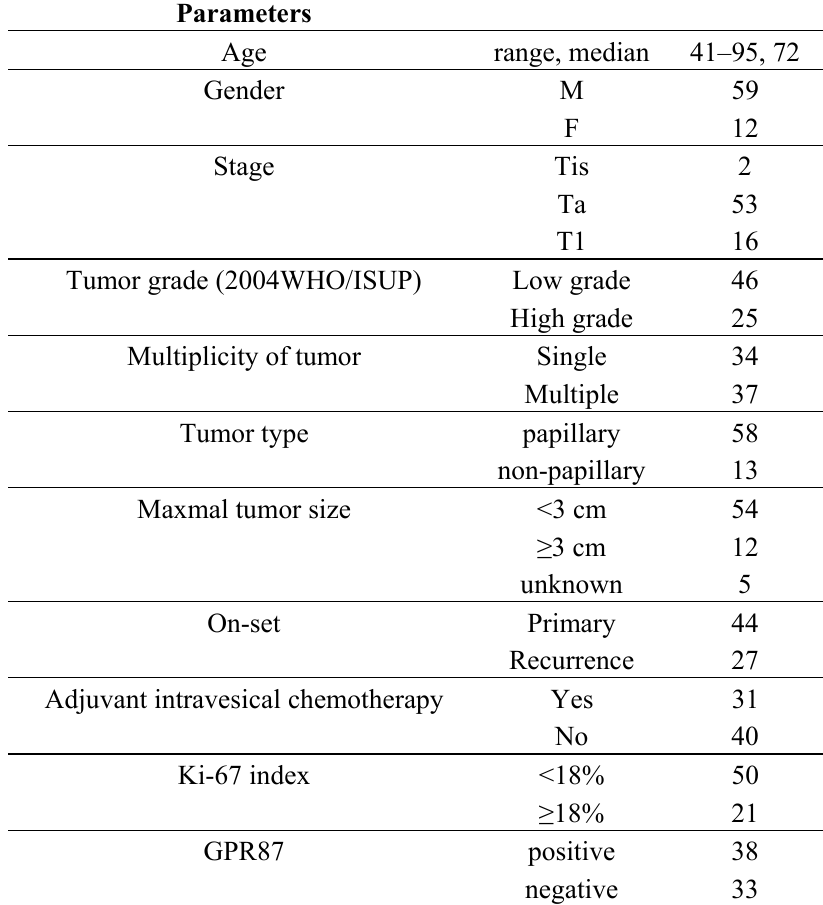
Table 2. Characteristics of patients with non-muscle invasive